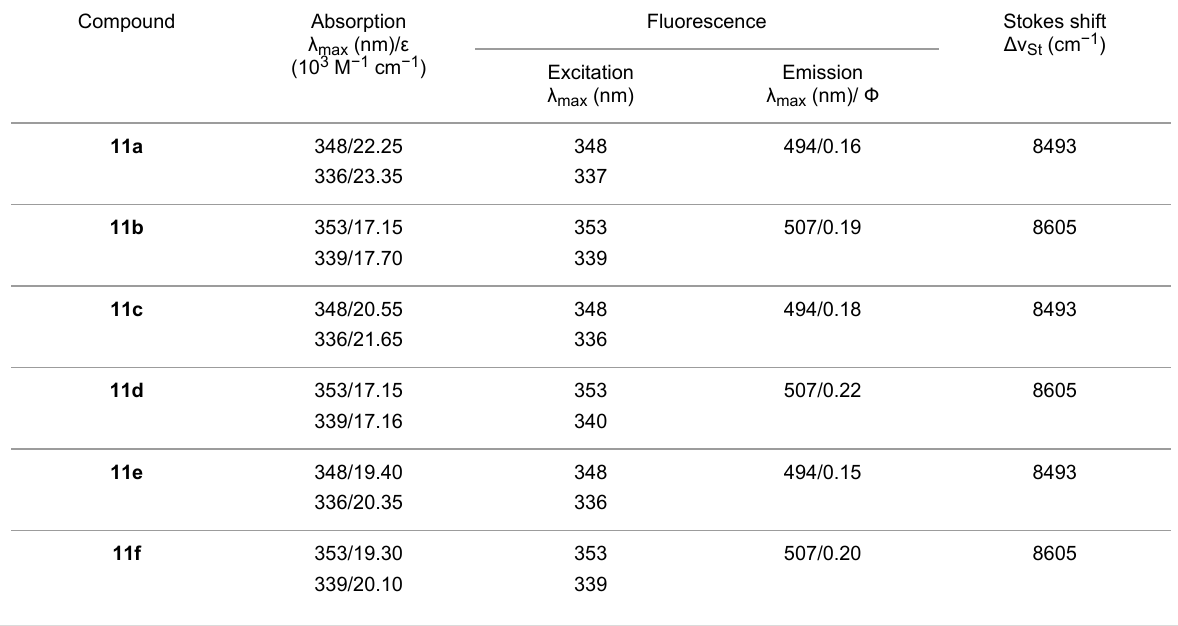
Table 3: Optical properties of 2-(2-alkoxycarbonyl-6-hydroxyphenyl)benzoxazoles 11a–f in heptane solution at 293 K. Ф – Quantum yield of the fluo- rescence. Compound